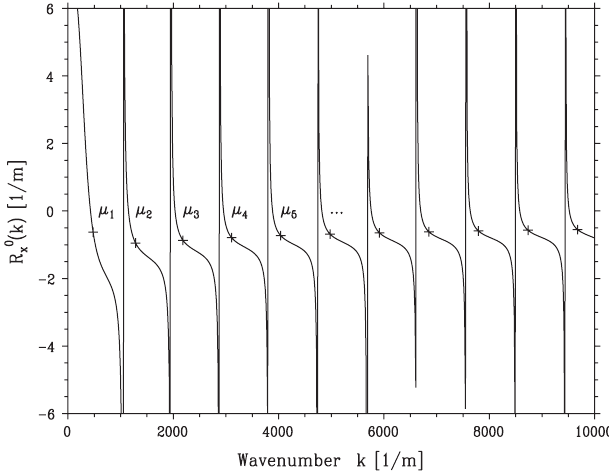
FIG. 9. Function R p x ð k Þ and the resonance points (cid:7) p m for the fundamental vertical mode ( p ¼ 0 ). The symbols ( þ ) on the line are the resonance points of the HE mode which are obtained numerically by a Newton search. The parameters used here ¼ (cid:2) x ¼ 5 cm , h ¼ 10 cm , (cid:3) ¼ 10 m , and are as follows: x b a (cid:5) ¼ 1 .